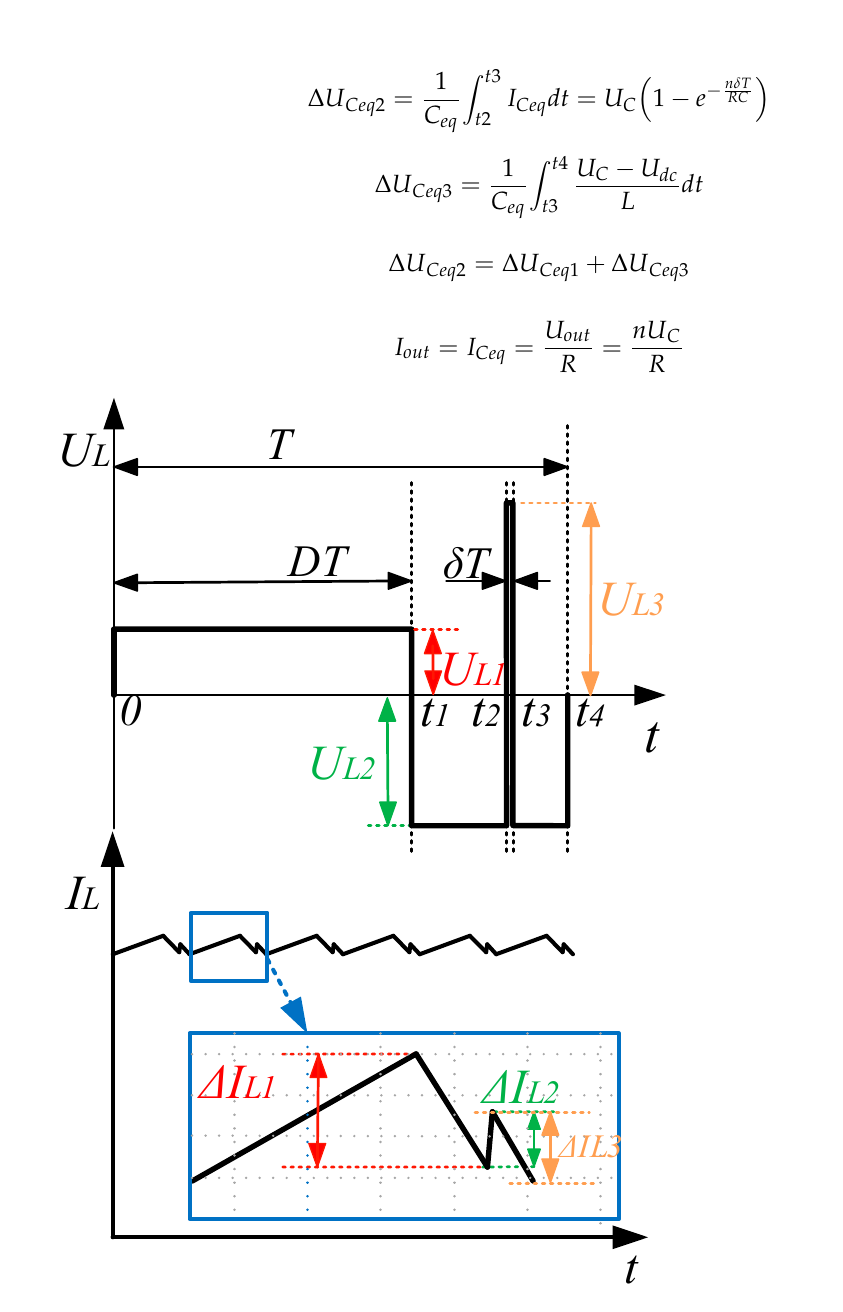
Figure 5. Waveform of inductor current and voltage.